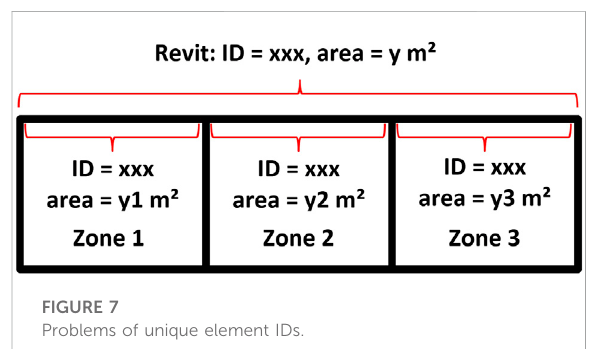
FIGURE 7 Problems of unique element